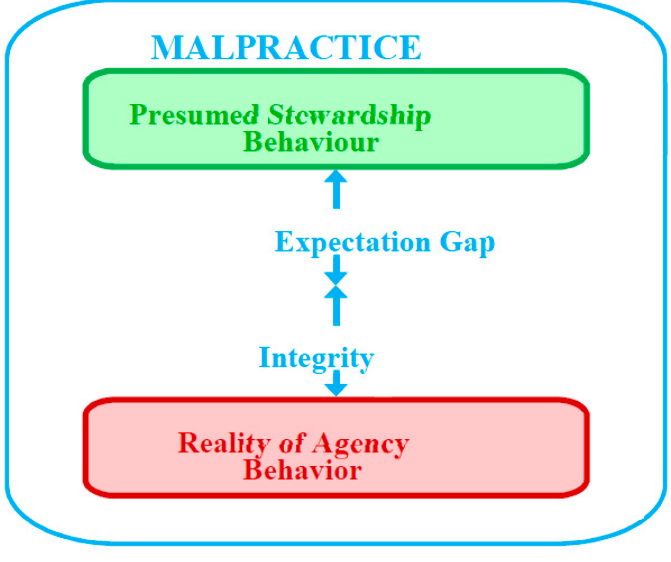
Figure 5. Figure 5. Malpractice.